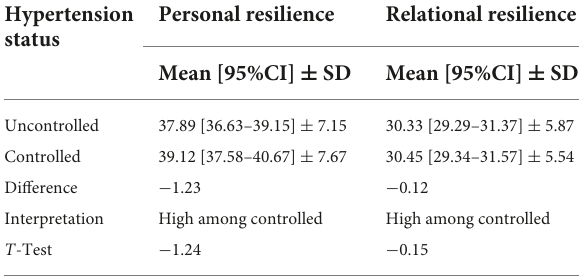
TABLE 5 Relationship between resilience and control of